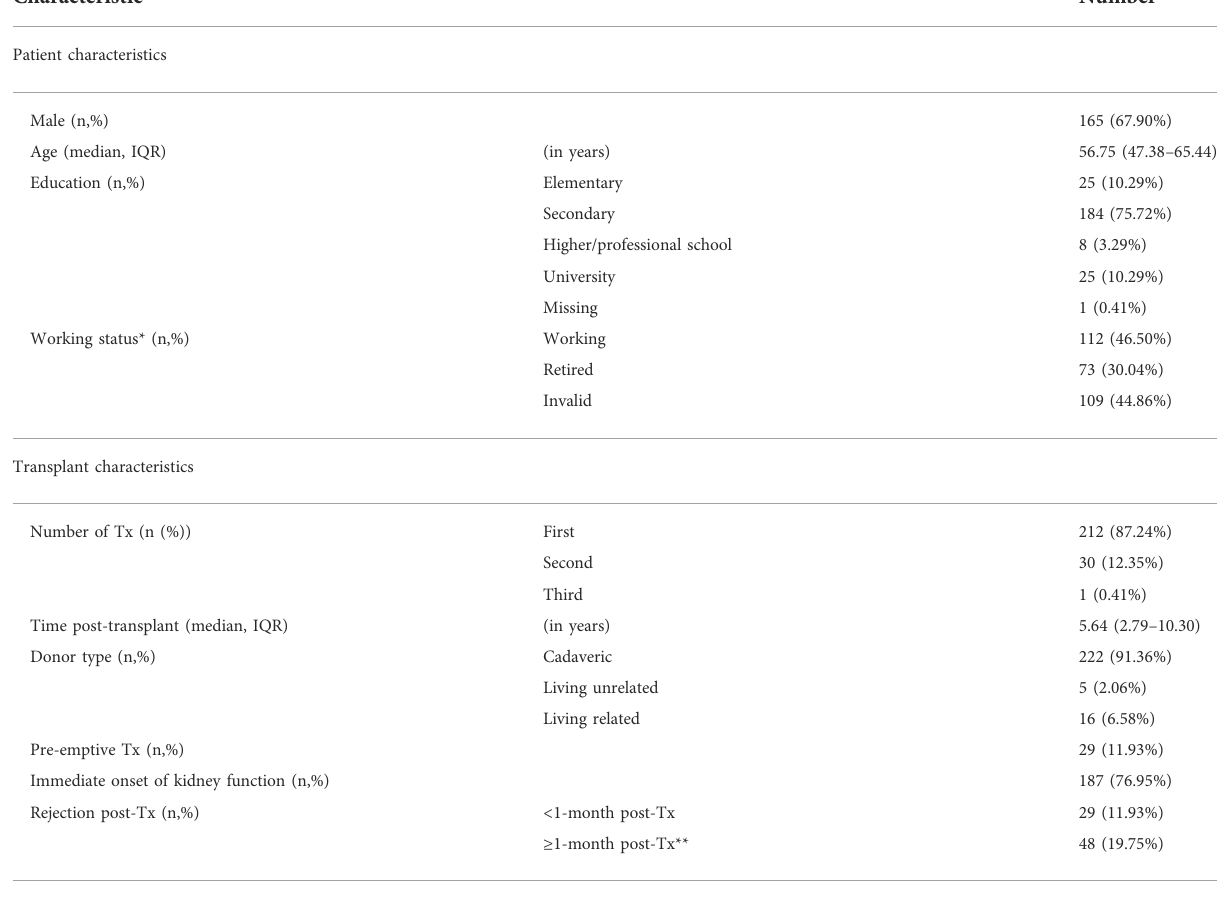
TABLE 1 Patient characteristics ( N =